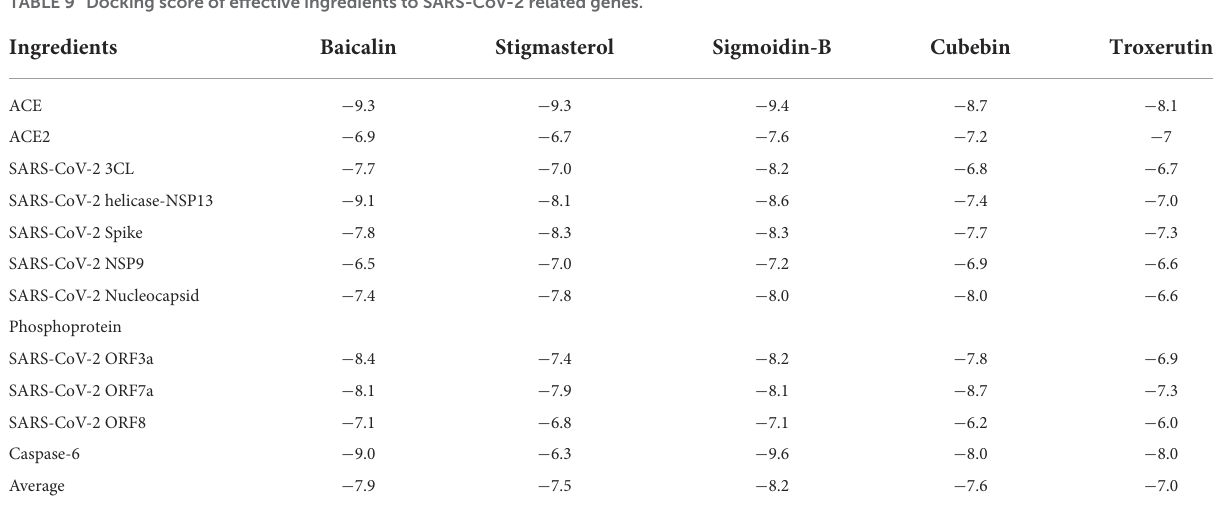
TABLE 9 Docking score of effective ingredients to SARS-CoV-2 related